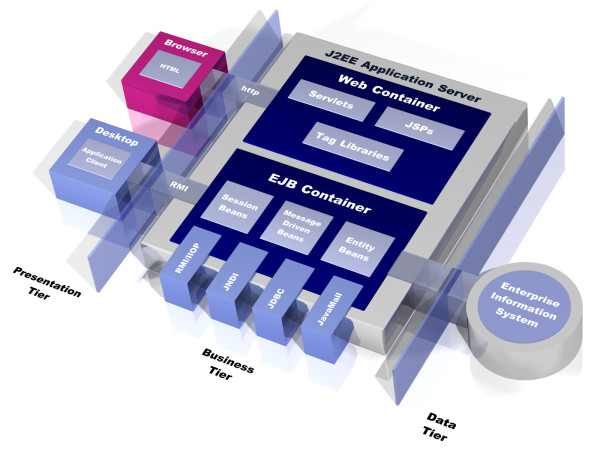
Three tier Java 2 Enterprise Edition software architecture. The J2EE platform simplifies the development of enterprise applications by providing standardized modular components like EJBs, JSP and Servlets. Furthermore it is providing a complete set of services to those components.